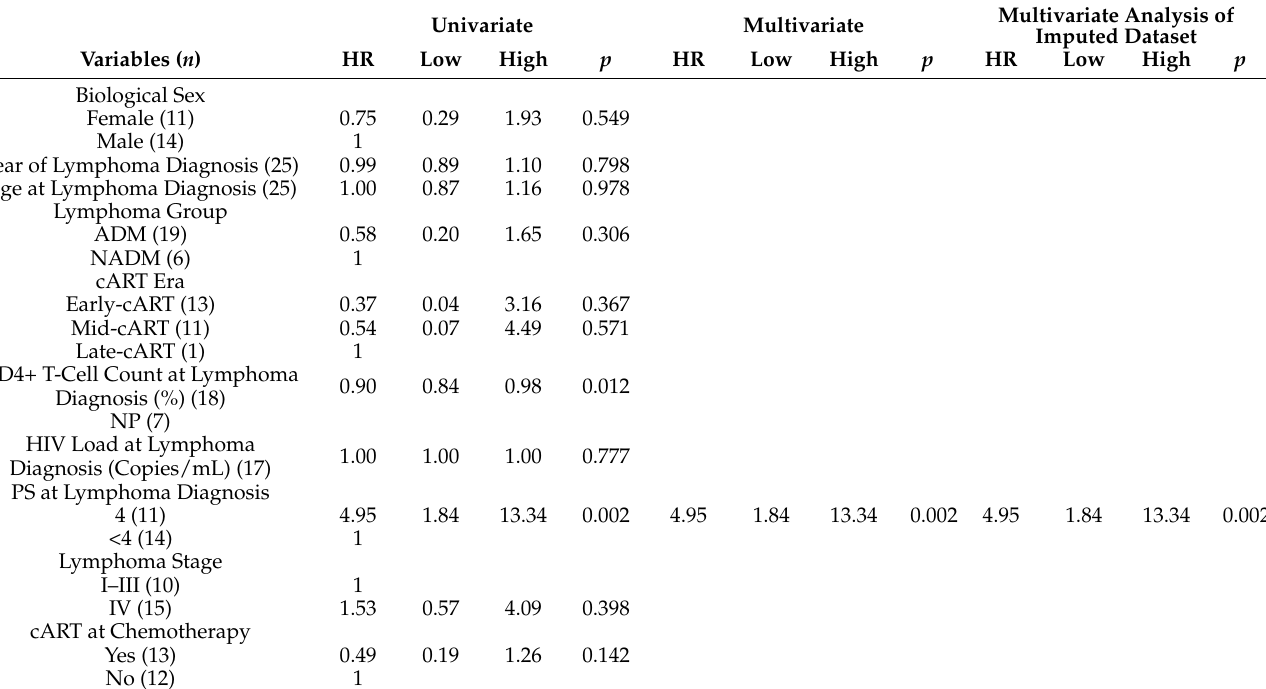
Table 3. Hazard ratio (HR) for events (EFS) (Cox proportional hazards models). Univariate Multivariate